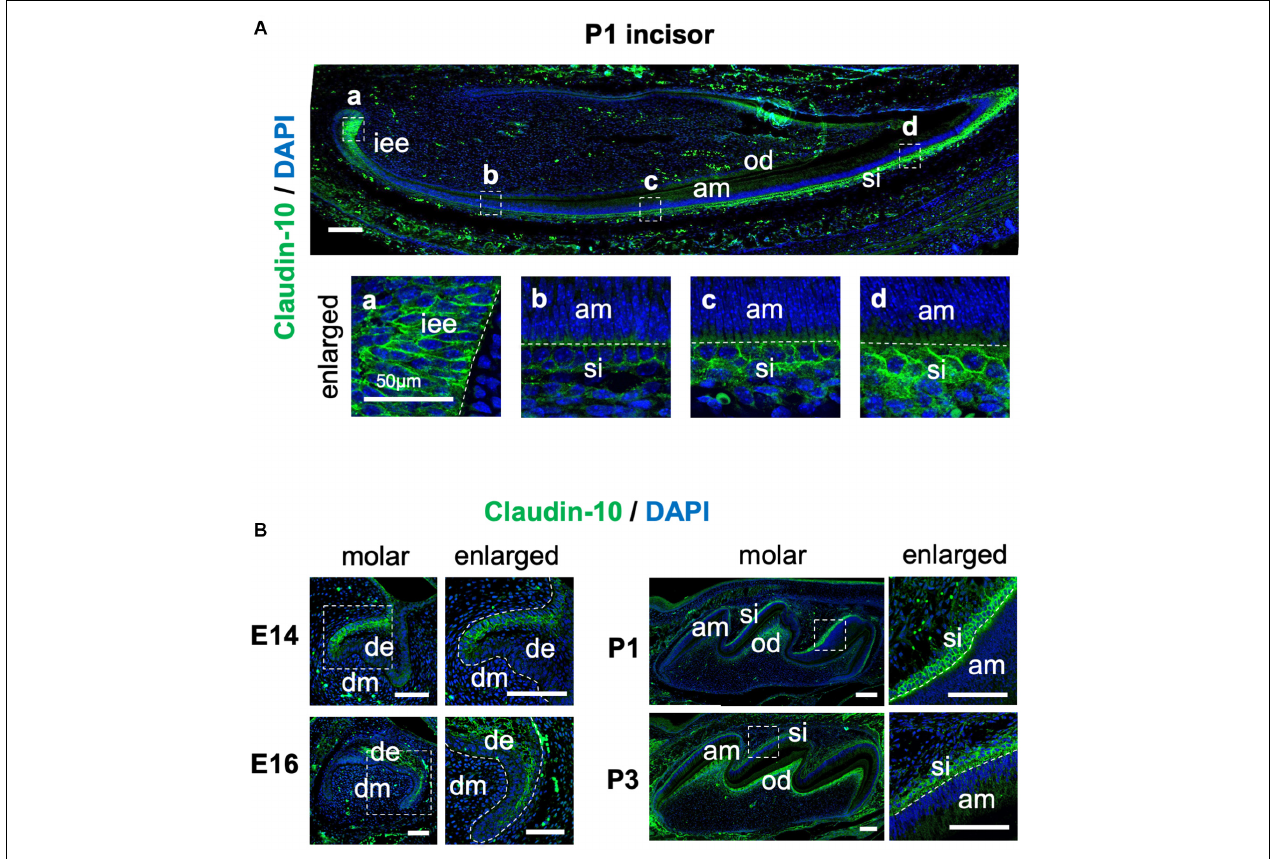
FIGURE 3 | Spatiotemporal expression pattern of claudin-10 during tooth development. (A) Immunofluorescence staining of claudin-10 in postnatal (P) day P1 mouse lower incisors. Dashed white boxes indicate the area enlarged in the lower panel. Scale bar, 100 µ m. Lower panel: enlarged image shown in the upper panel. Scale bars, 50 µ m. (B) Immunofluorescence staining of claudin-10 in embryonic (E) day E14, E16, P1, and P3 mouse molar tooth germs. Green, claudin-10; blue, DAPI (4’,6-diamidino-2-phenylindol); iee, inner enamel epithelium; si, stratum intermedium; am, ameloblast; od, odontoblast; de , dental epithelium; dm , dental mesenchyme. Dashed white boxes indicate the area enlarged in the right panel. Scale bars, 100 µ